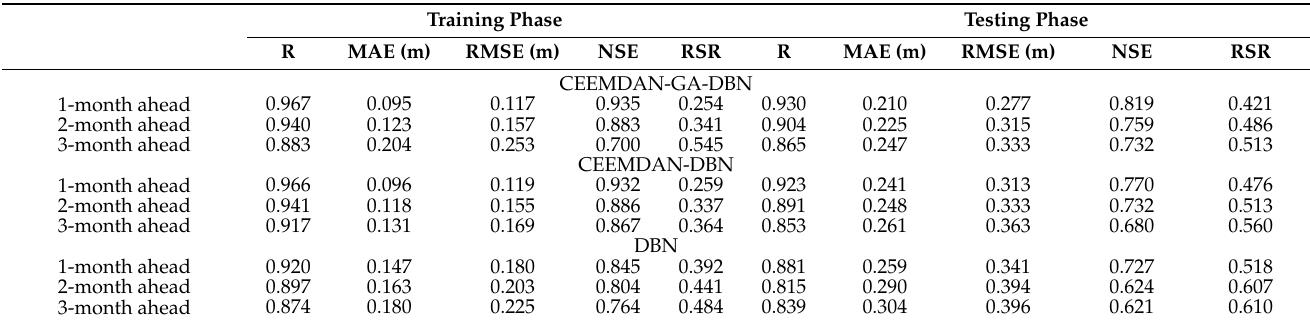
Table 3. Performance metrics of the hybridized CEEMDAN-GA-DBN, CEEMDAN-DBN and DBN models in the training and testing phases for 1-, 2- and 3-month ahead GWL forecasting of Well